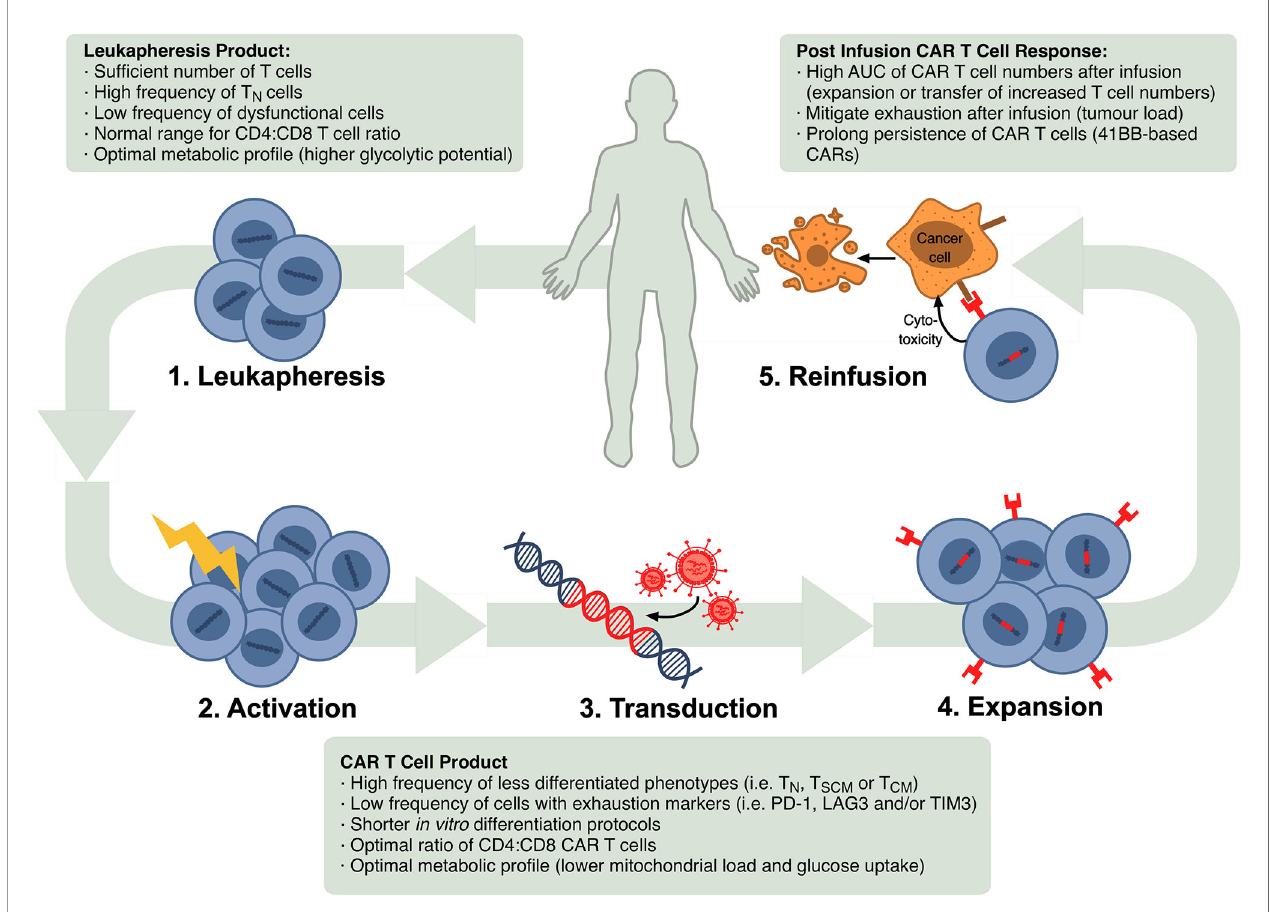
FIGURE 1 | Schematic of steps in the autologous CTT protocol and markers that have been con fi rmed or are possible correlates of CTT ef fi cacy in the leukapheresis product, CAR T cell product and after re-infusion. In CTT, 1) leukocytes are isolated from the patient ’ s blood via leukapheresis, 2) T cells are activated in vitro , 3) activated T cells are stably transduced to express the CAR, commonly using a lentiviral or retroviral vector, 4) CAR-expressing T cells are expanded and 5) infused back into the patient where they can target and eliminate malignant